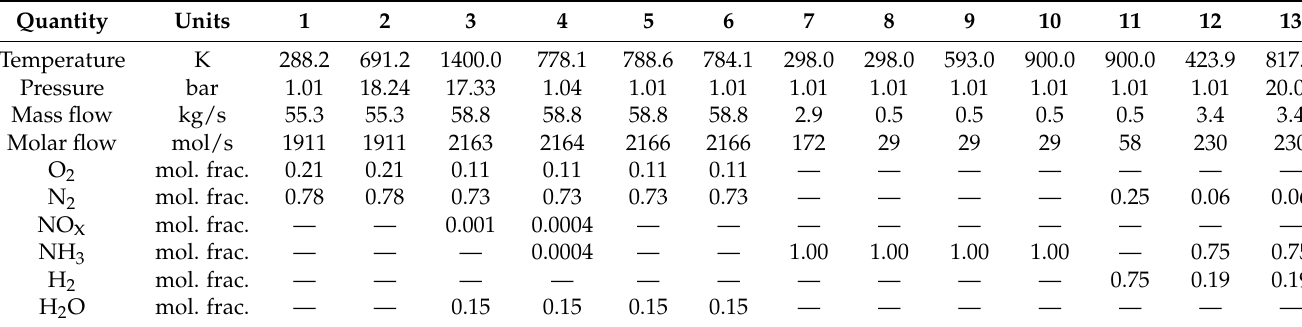
H 2 O — Table 12. The state points corresponding to the process flow diagram given by Figure 13 for a single 22 MW GT used by a naval frigate running in trail shaft mode. The naval frigate is equipped with 4 GTs, but these data describe the performance of a single GT at